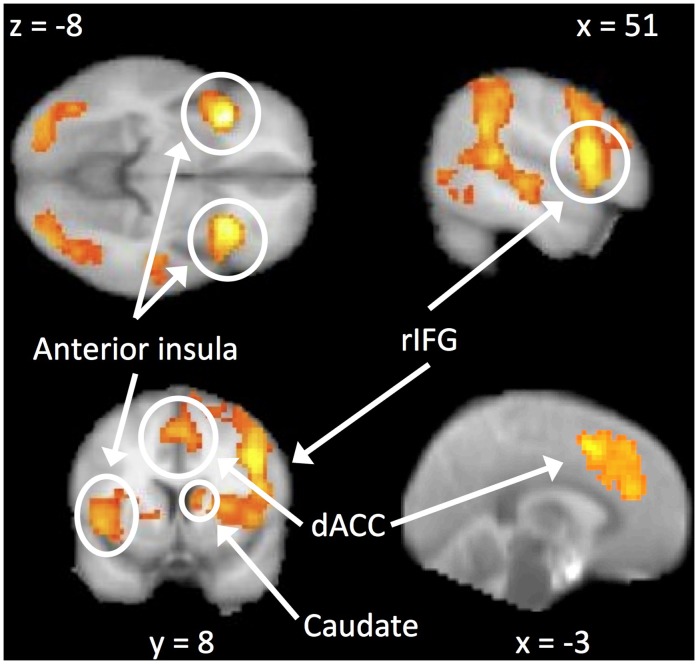
The main effect of response inhibition.Activations were observed in bilateral anterior insula (left images, peak MNI: −36 20 −8 and 33 17 4), dACC (bottom images, −9 23 31), rIFG (top right and bottom left, 51 14 13), and caudate (bottom left, 12 8 10).